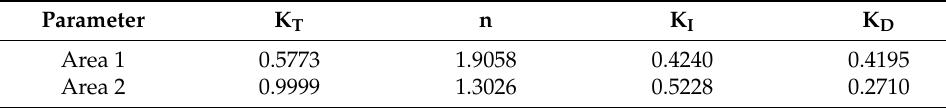
Table 9. TID controller parameters with a 0.2 s delay.